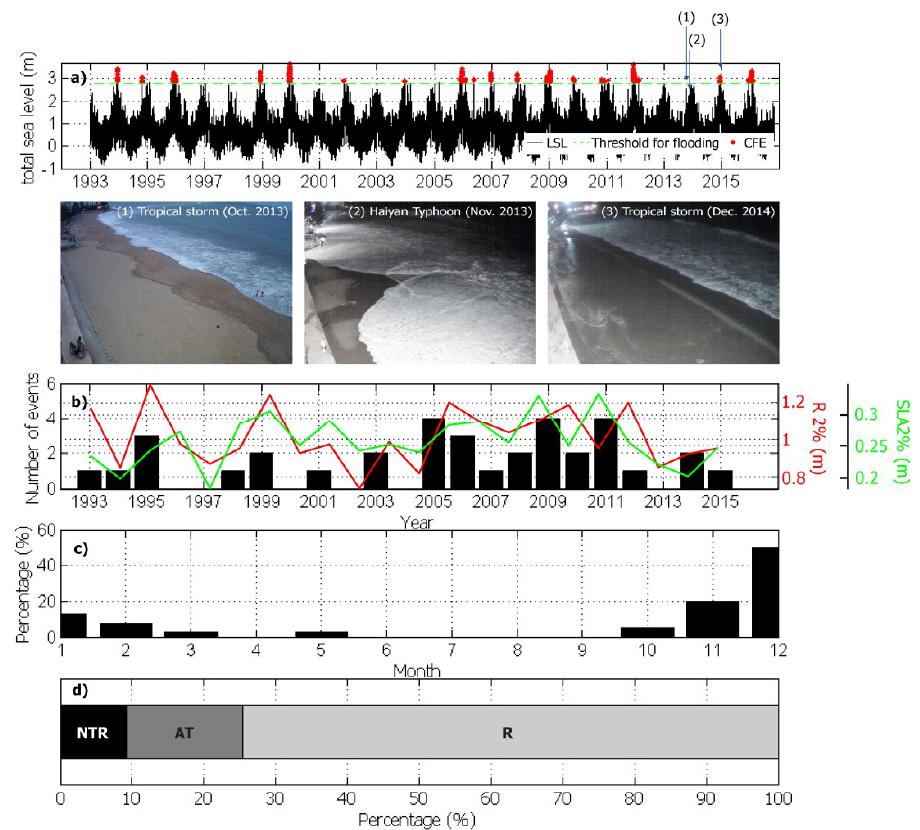
Figure 3. ( a ) Total water level (TWL) time‐series indicating the threshold for coastal flooding events (CFE) (dashed green line) and the records that exceeded that threshold (red dots); the blue vertical lines indicate three distinct events where distinct impacts where observed—each number (event) is linked to the field photo in the panel below; the second panel shows three video snapshots of different extreme events recorded locally and used for a qualitative validation; ( b ) number of CFEs per year for the period 1993–2015 with the overlap of the annual 2% of the exceedance of R (R2%; in red) and altimetry NTR (green); ( c ) monthly percentage of occurrence of CFEs showing the main winter monsoon from October (month 10) to March (month 3); ( d ) and the average contribution (%) of the different TWL components to the CFE.